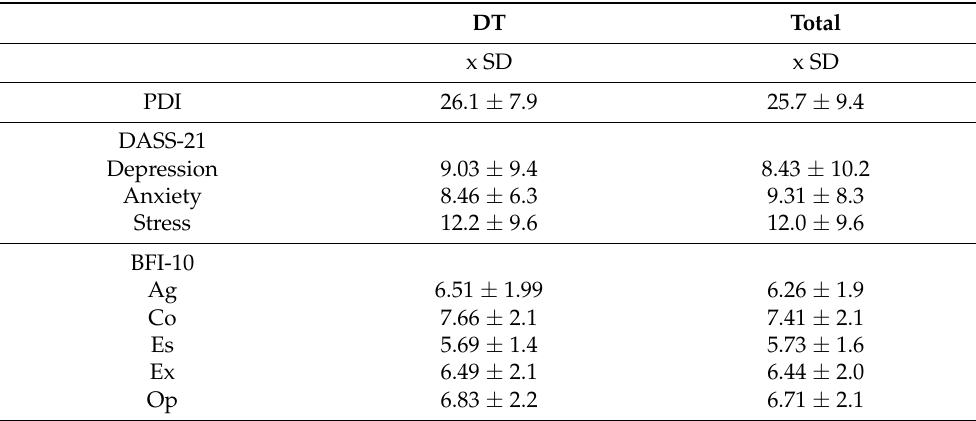
Table 2. Raw score (mean/standard deviation) by psychological evaluations distributing sample in patient condition